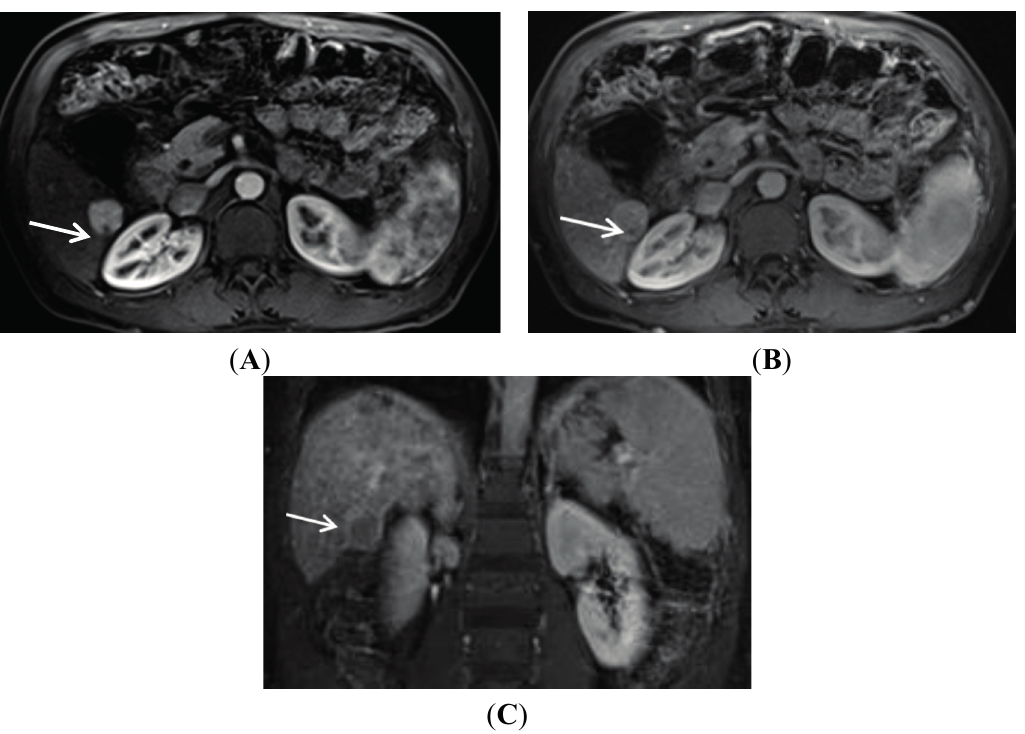
Figure 1. Typical contrast enhancement for MRI diagnosis of HCC. ( A ) On a late arterial phase image, a 2.3 cm HCC (arrow) demonstrates unequivocal arterial enhancement relative to the surrounding liver; ( B ) On the portal venous phase of the same exam, the hepatocellular carcinoma (arrow) has decreased in enhancement relative to the earlier arterial phase while the hepatic parenchyma has increased in signal intensity; ( C ) A coronal image obtained in the equilibrium phase demonstrates the hepatocellular carcinoma (arrow) as being of lower signal intensity than the adjacent cirrhotic parenchyma (“washout”). Additionally present is the delayed capsule or so-called pseudo-capsule, which helps further solidify the imaging diagnosis of hepatocellular